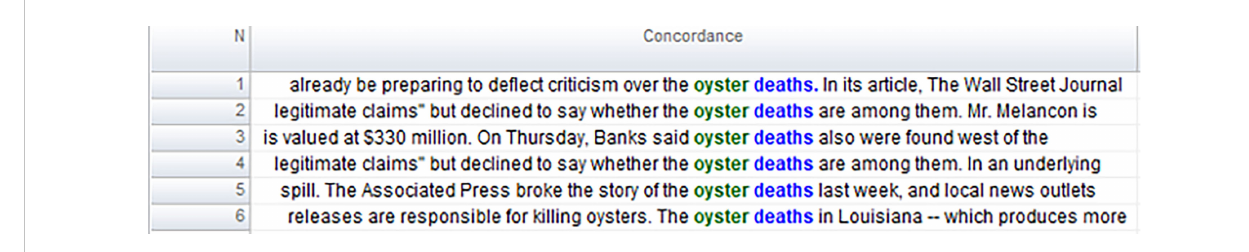
FIGURE 1 Concordance lines for the collocation of the node OYSTER* and the collocate DEATHS from the during-DWH time span